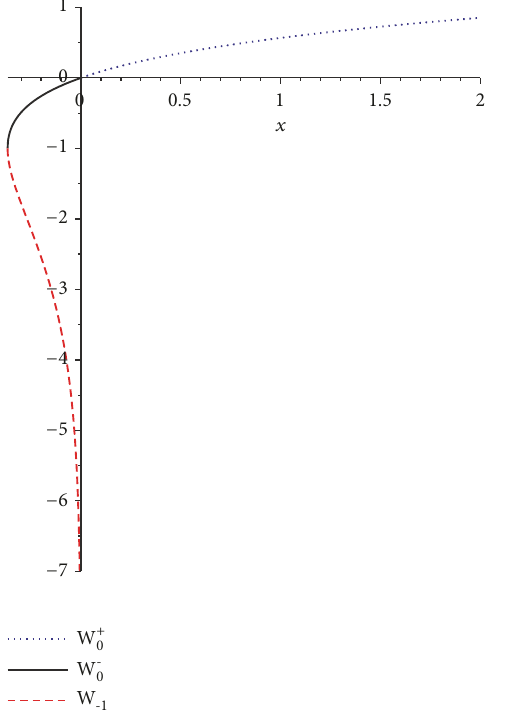
Figure 1: The two real branches of the Lambert W Function. 𝑊 0 (𝑥) is the upper branch and 𝑊 −1 (𝑥) is the lower